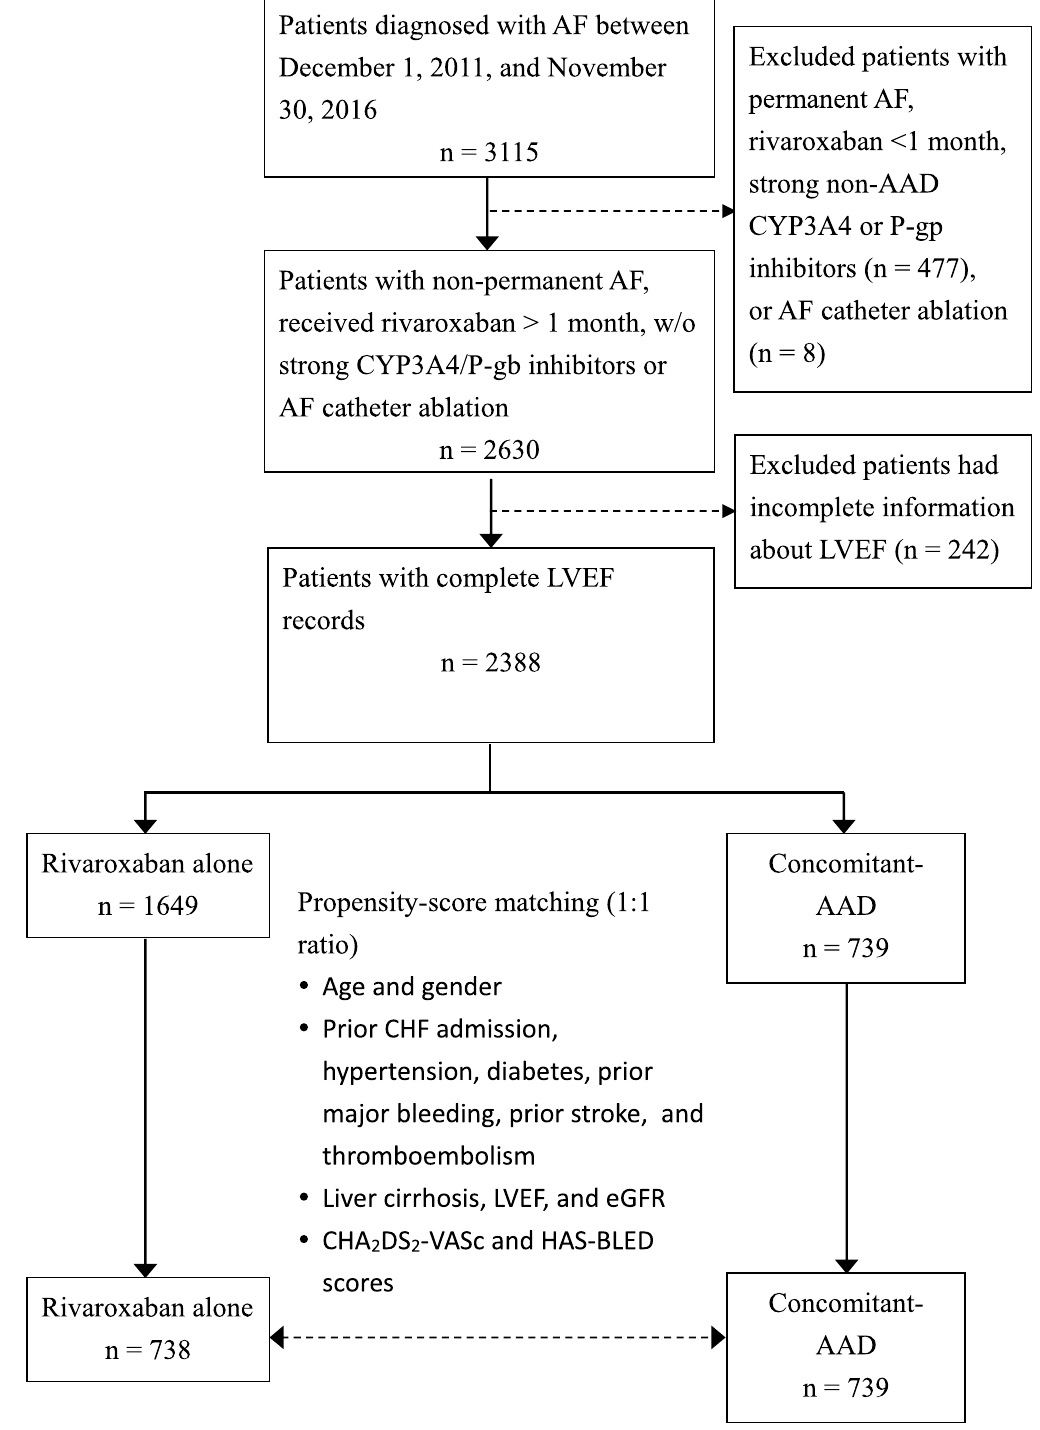
Figure 1. Flow diagram of patient selection. AADs, antiarrhythmic drugs; AF, atrial fibrillation; CHF, congestive heart failure; eGFR, estimated glomerular filtration rate; LVEF, left ventricular ejection